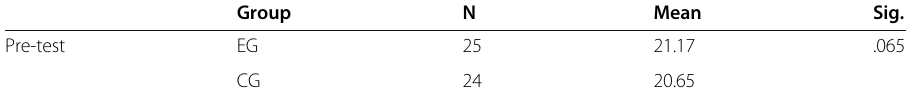
Table 2 Descriptive achievement pre-test